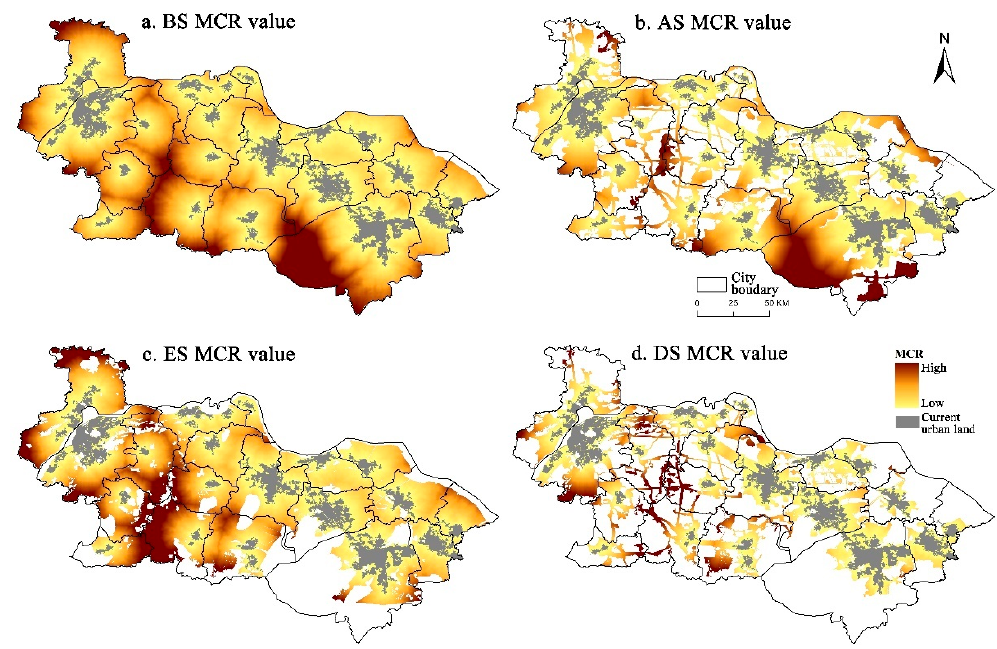
Figure 6. Minimum cumulative resistance (MCR) results of urban spatial expansion (USE) under four scenarios.